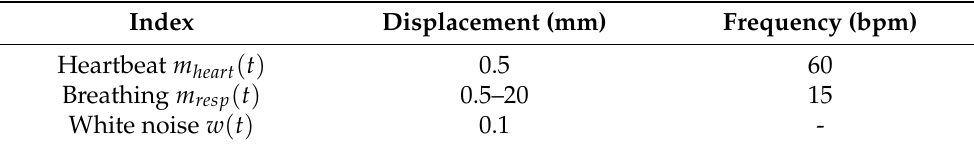
Table 2. Parameters used in the simulation of the chest vibration